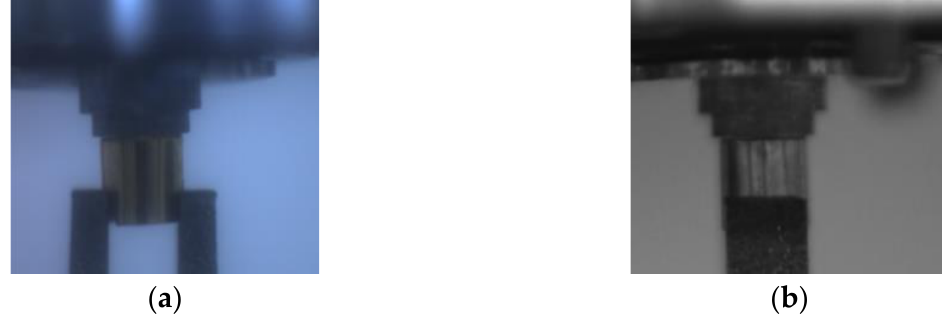
( b ) Figure 16. Size calibration of CCD. ( a ) Draw lines on the hohlraum to mark its front size; ( b ) Draw a line on the hohlraum to mark its left side size. The positional adjustment of the two components was done in the third session. The current TMP component posture was first identified in the posture adjustment process by drawing lines for the TMP component in the CCD camera 1 and CCD camera 2 pictures, respectively. The part posture calibration for the CCD camera 1 picture and CCD camera 2 images is shown in Figure 1 7a,b. The posture deviations in the assembly system’s coordinate system are θ x and θ y , and the position deviations are e x , e y , and e z , respectively, based on the picture calibration results. According to the kinematic analysis of the six DoF micromotion stage, it is known that after the posture adjustment, the kinematic model position deviation fulfills    −+++= −+++−−= +−−−++−= xyy yxyxyx zyxxyx ehhdhz ehhhdhy ehdhhdhx 2362 12361 362361 sin)(cos sinsinsincos)(cos sincoscoscos)(sin   